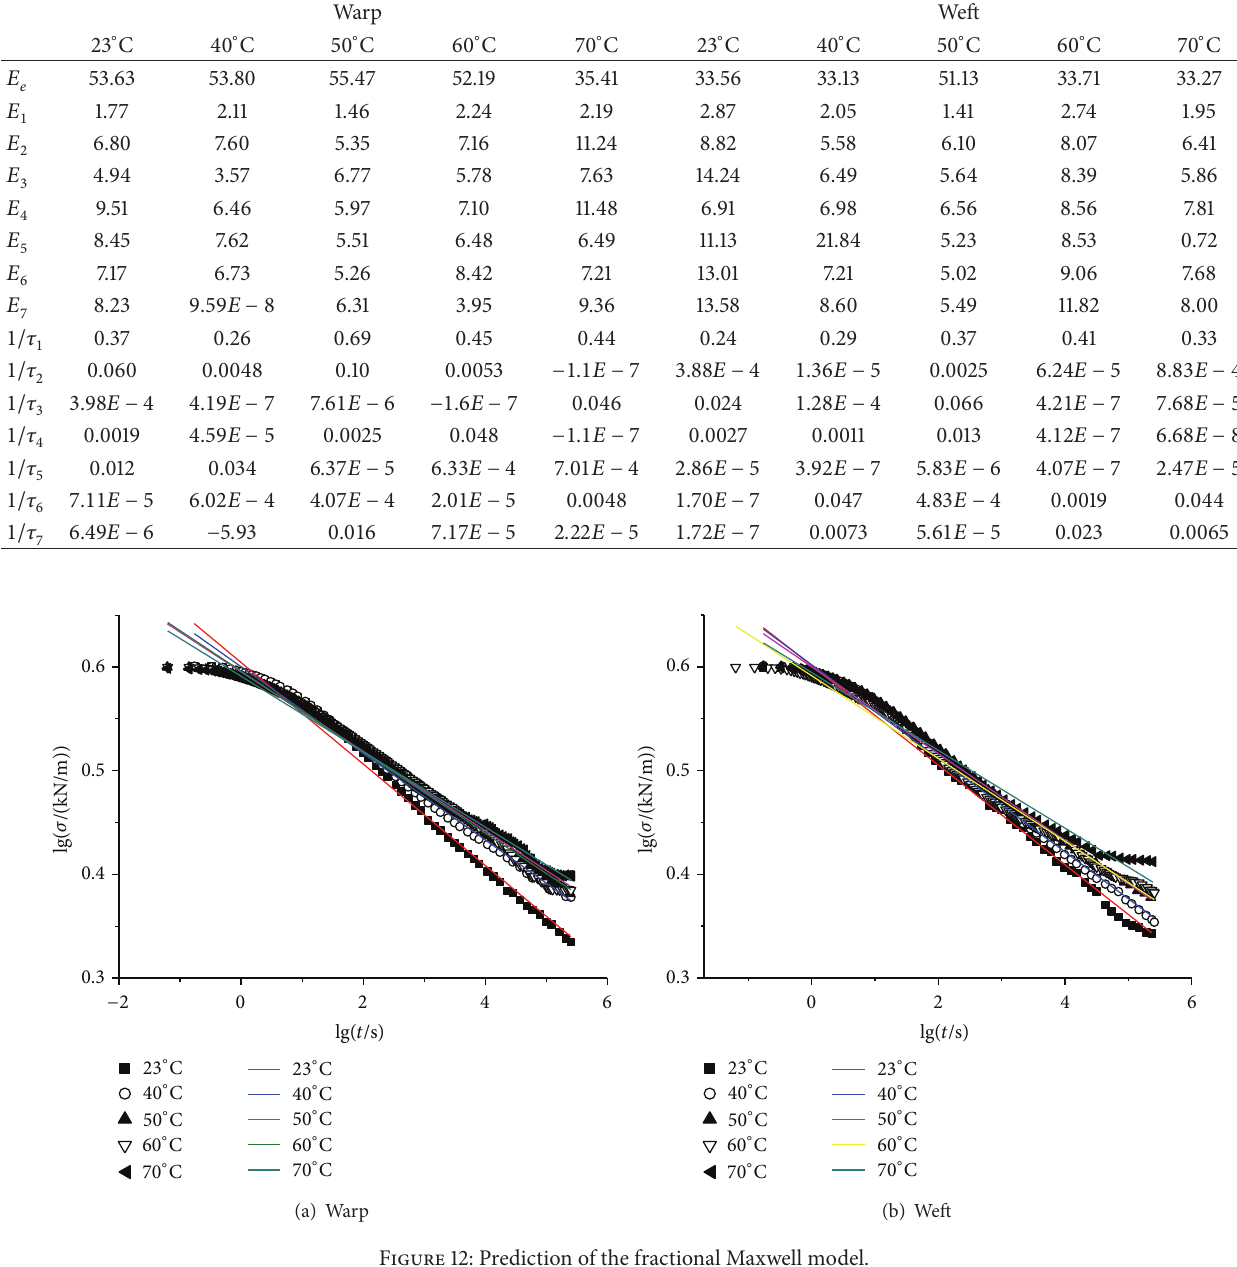
Table 3: Parameter results of the generalized Maxwell model (seven-component model). Warp